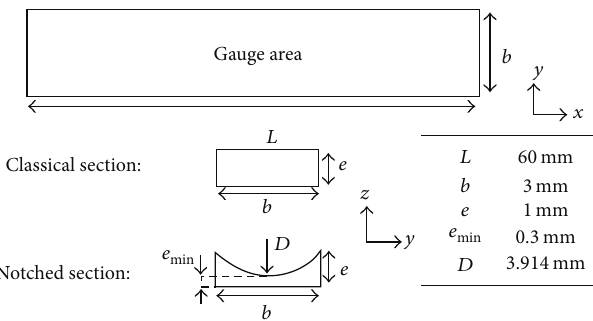
Figure 6: Geometry and dimensions of the classical and proposed notched shear specimens used in